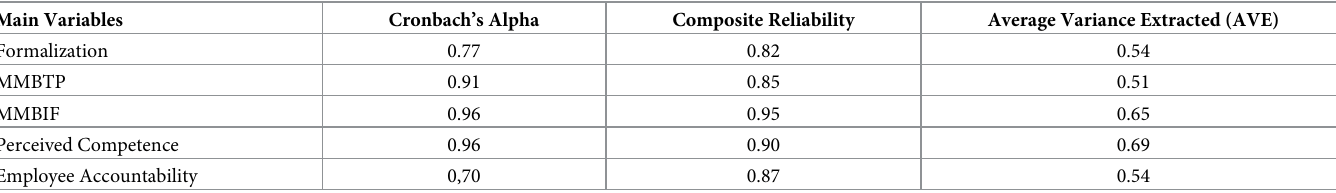
Table 2. Construct reliability and validity.